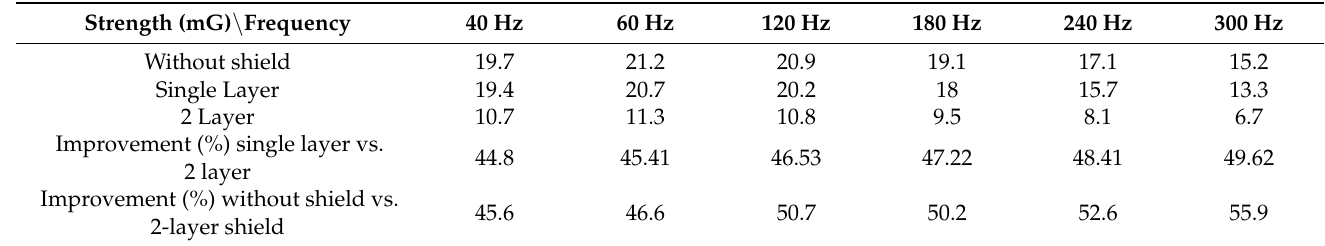
Table 10. The comparisons of shielding capability for the PMCS for the multi-layer structures without holes.